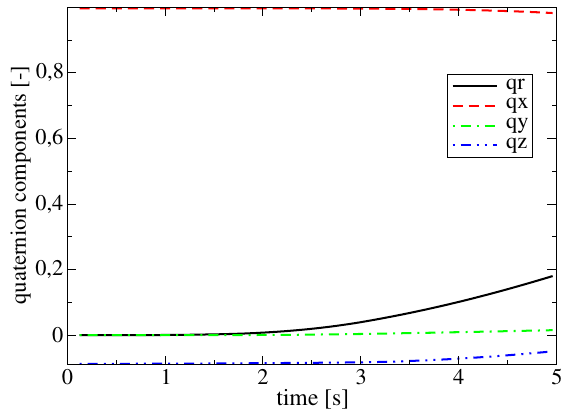
Figure 13. Time evolution of the components of the quaternion describing the attitude of the object released at an azimuthal angle of 270